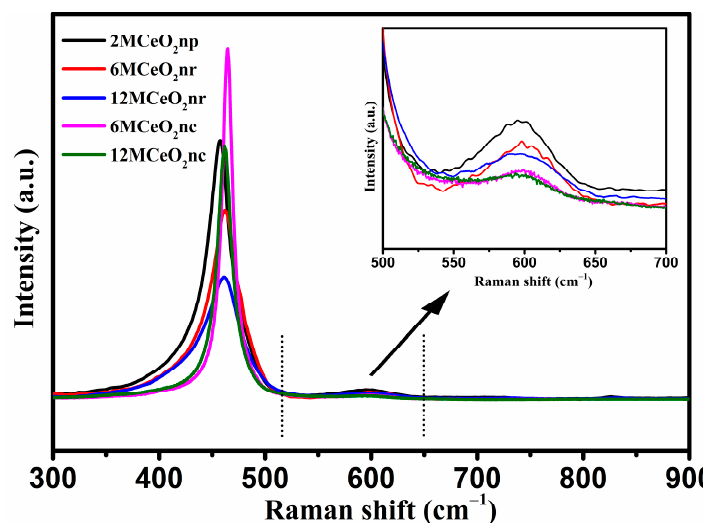
Figure 6. Raman spectra of various CeO 2 nanomaterials.